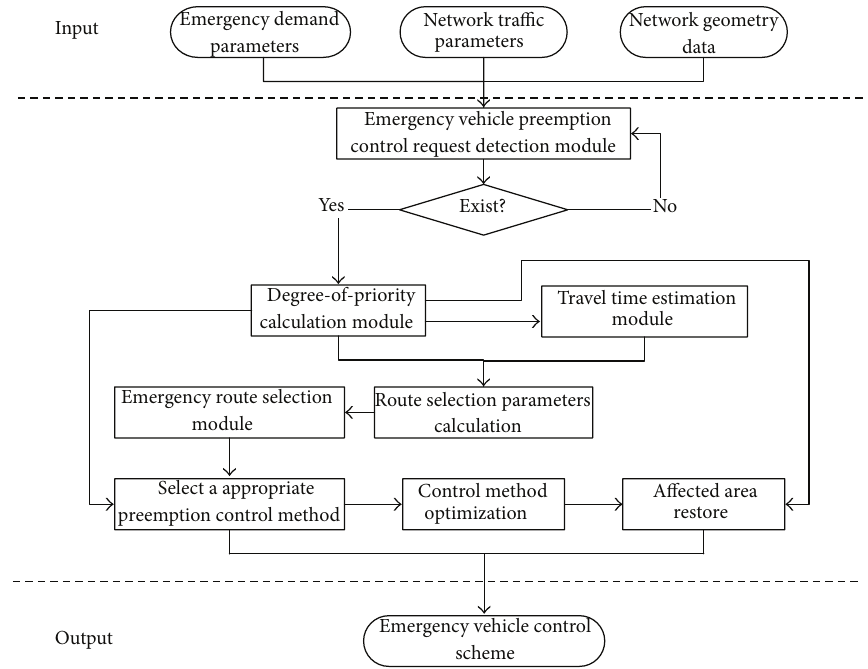
Figure 1: Structure of degree-of-priority based signal preemption